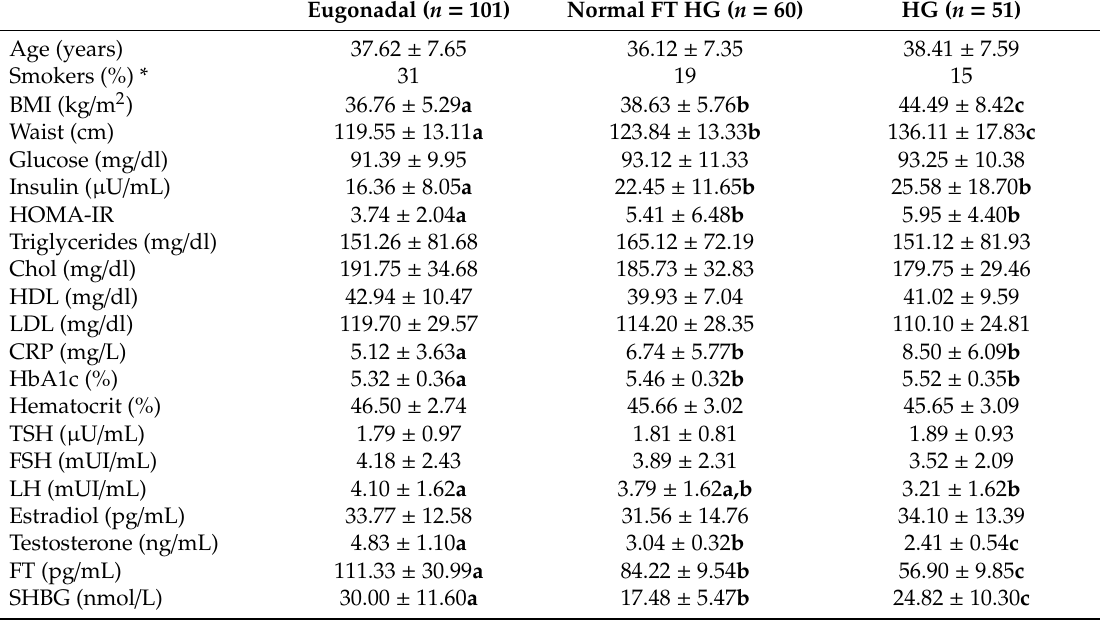
Table 1. Anthropometric and analytical variables among the study groups. Values are given as the means and